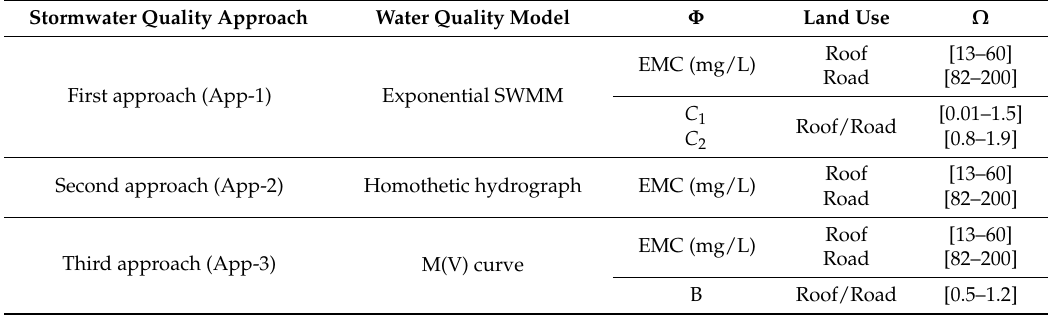
Table 1. Summary of total suspended solids (TSS) modeling approaches and the corresponding